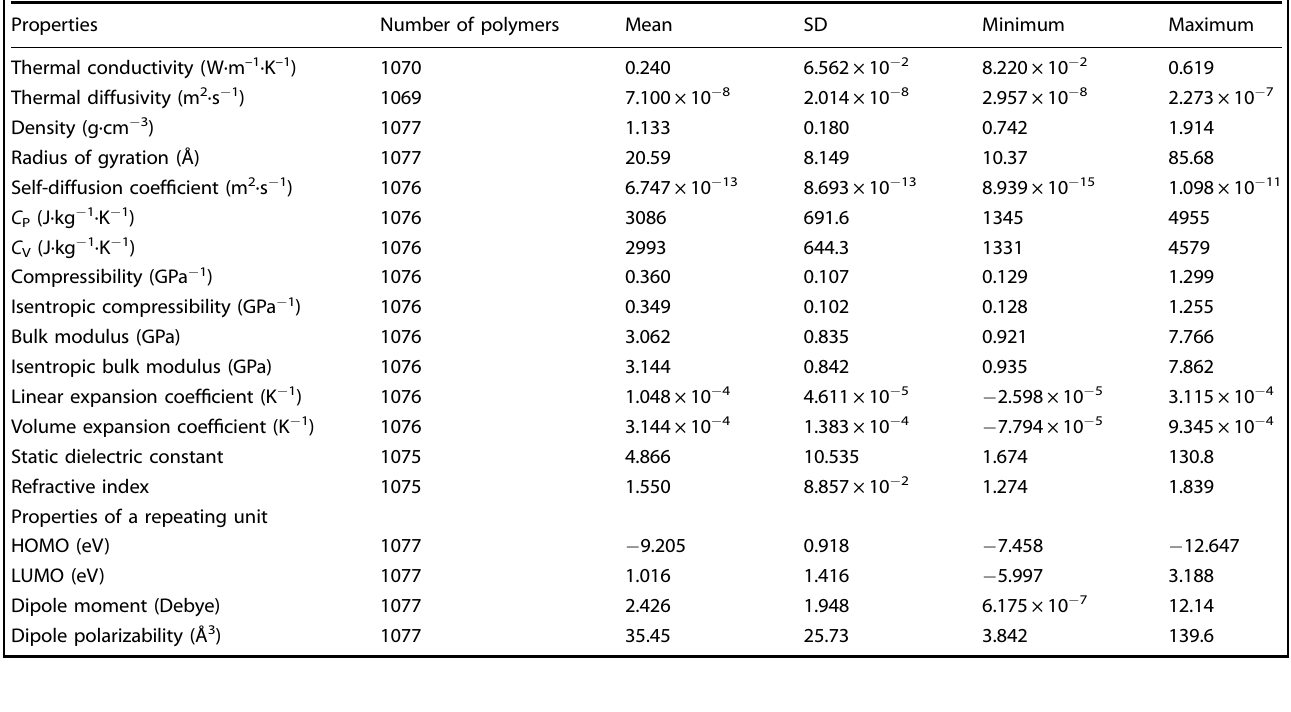
Table 1. Summary statistics of the calculated properties, including the mean, standard deviation (SD), minimum, and maximum.